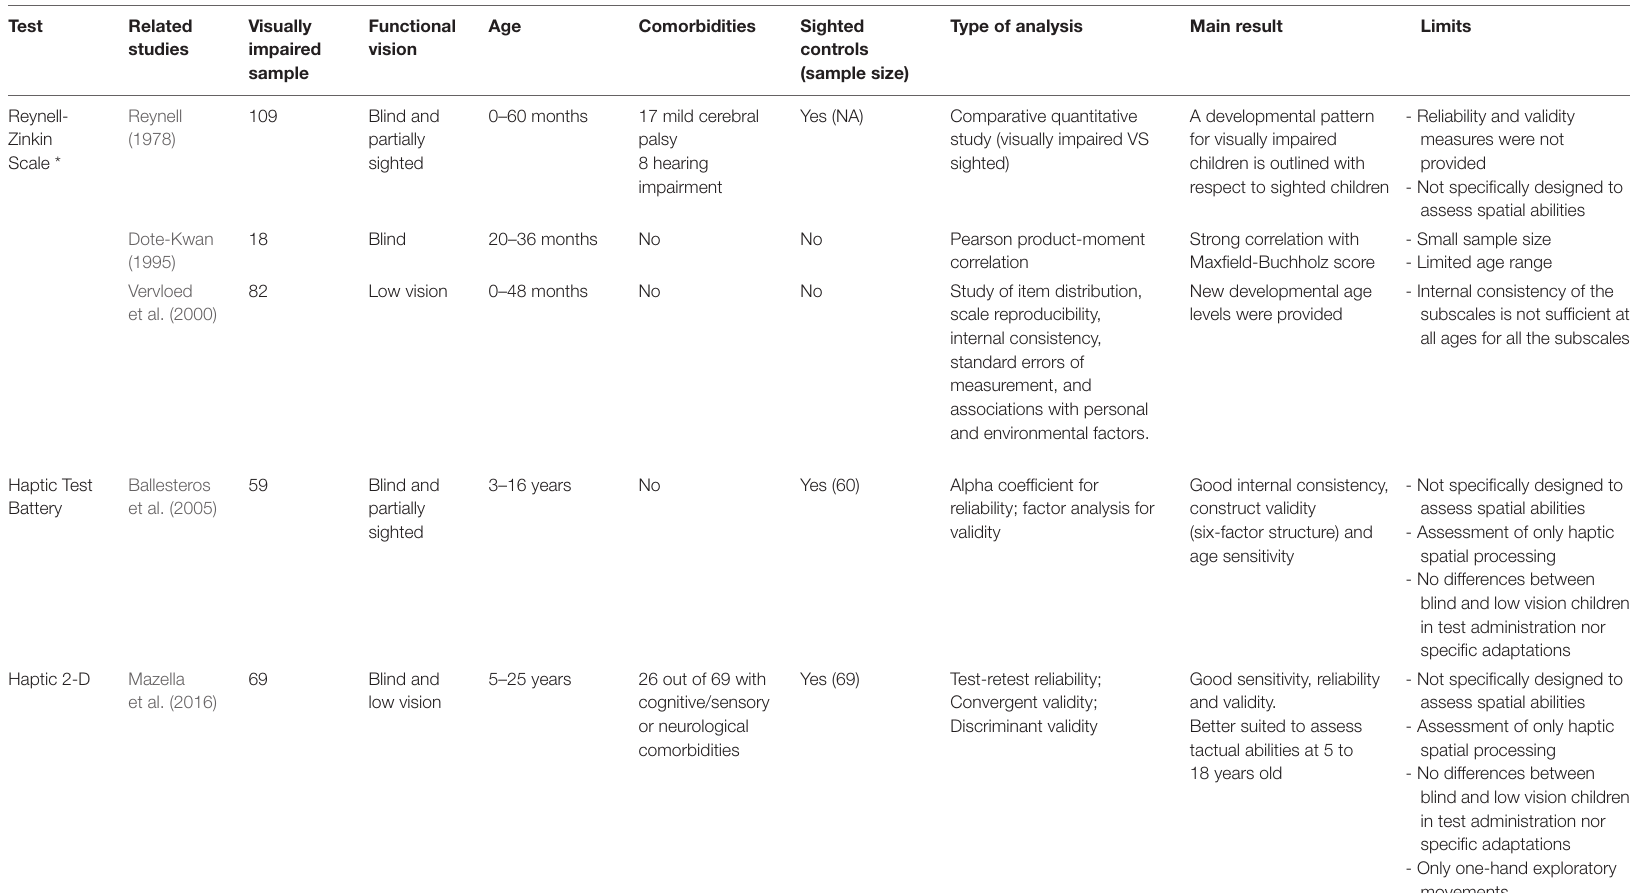
TABLE 1 | List of standardized tests to assess spatial cognition in visually impaired children with their main related studies.